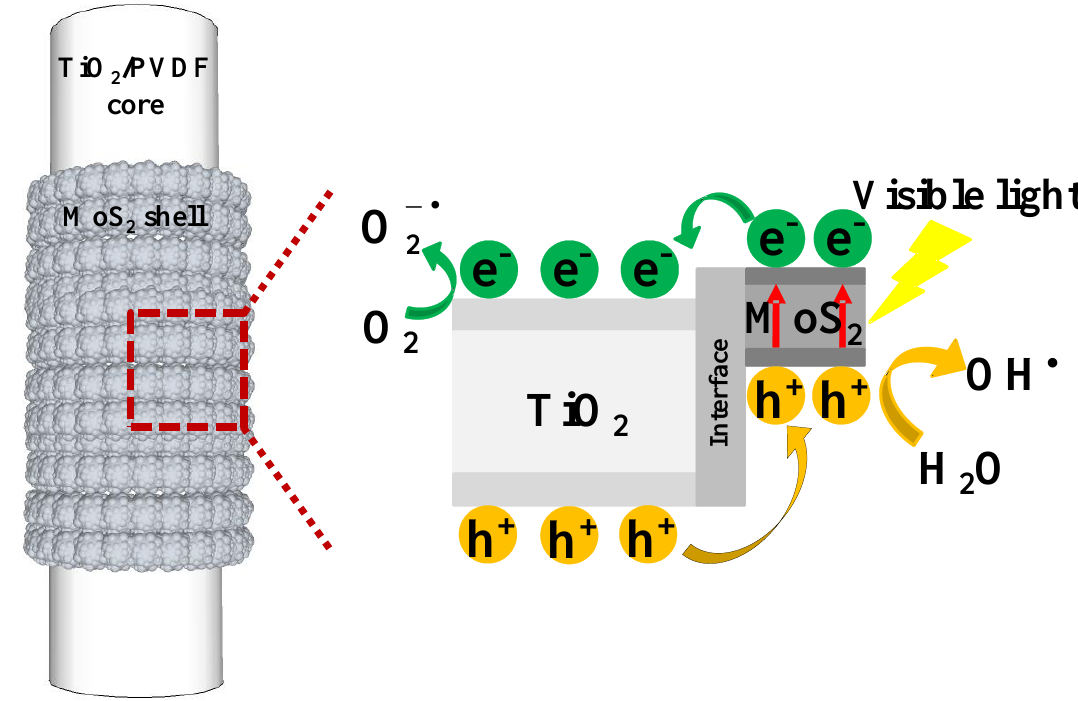
Figure 12. Schematic illustration for the photo-generated electron-hole separation and transfer process between TiO 2 /PVDF core and MoS 2 shell.